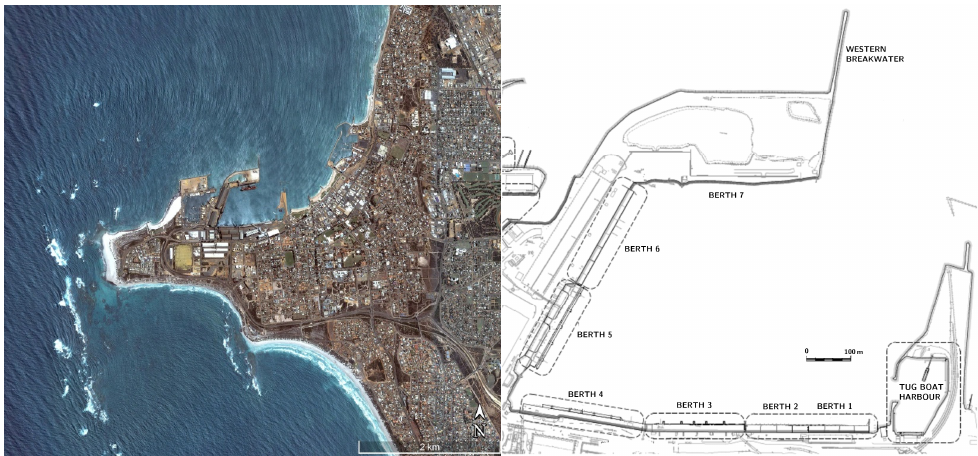
Figure 1. Aerial photo of Geraldton ( left ; source Google Earth) and layout of the Geraldton Port showing the commercial Berths N° 1 through 7 ( right ).